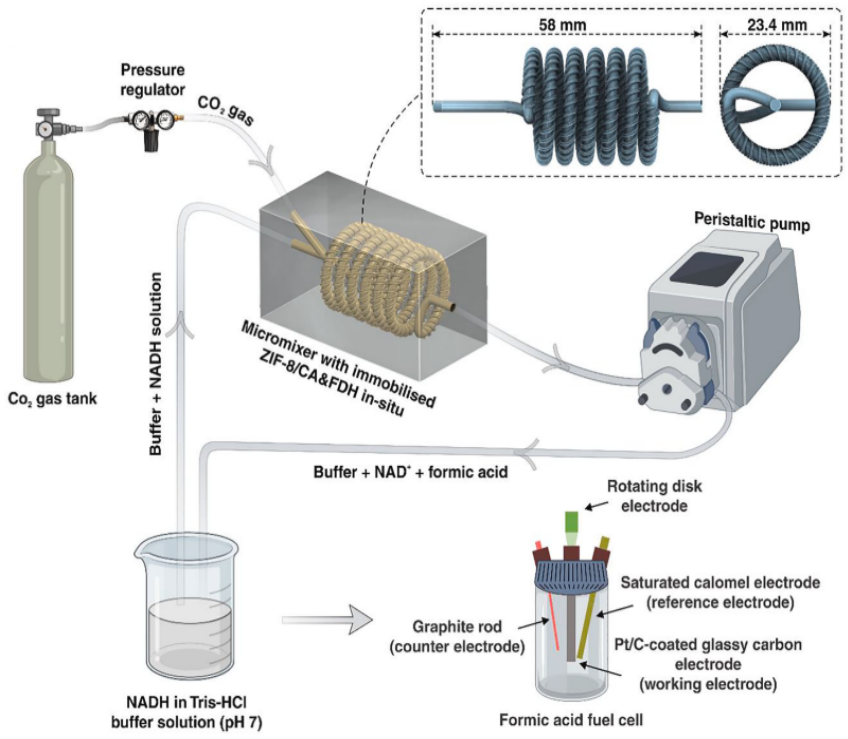
Figure 3. Schematic diagram of the micromixer setup used by Chai et al. [40] for the enzymatic cascade conversion of CO 2 to HCOOH.